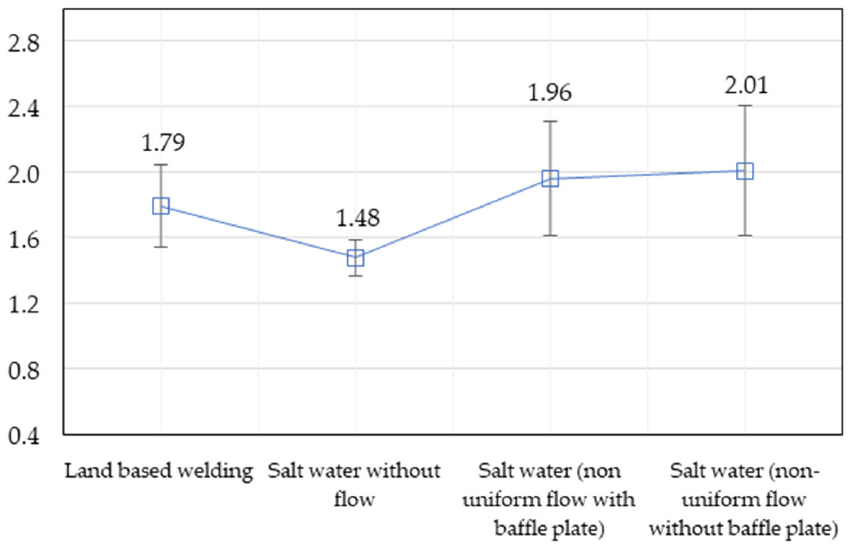
Figure 16. Penetration depth on land-based welding and wet-salt underwater welding specimens. According to the welding penetration depth graph, the wet-salt underwater welding specimens with the non-uniform flow with a baffle plate have the deepest penetration depth. As shown in Figure 17, this is caused by droplets that form when the molten weld metal flows and is pushed by the opposing flow of water. Water will flow from the molten weld metal towards the rear of the welding electrode, where it gathers, allowing more heat energy to be absorbed by the base metal [8]. The effect of the molten weld metal being driven by the water flow is greater than the rise in cooling rate, which leads the weld metal to penetrate deeper.